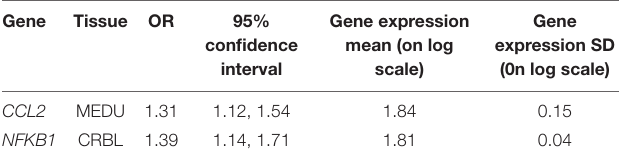
TABLE 3 | Statistically significant total causal effect for CCL2 in MEDU and NFKB1 in CRBL after FDR multiple testing correction. Gene Tissue